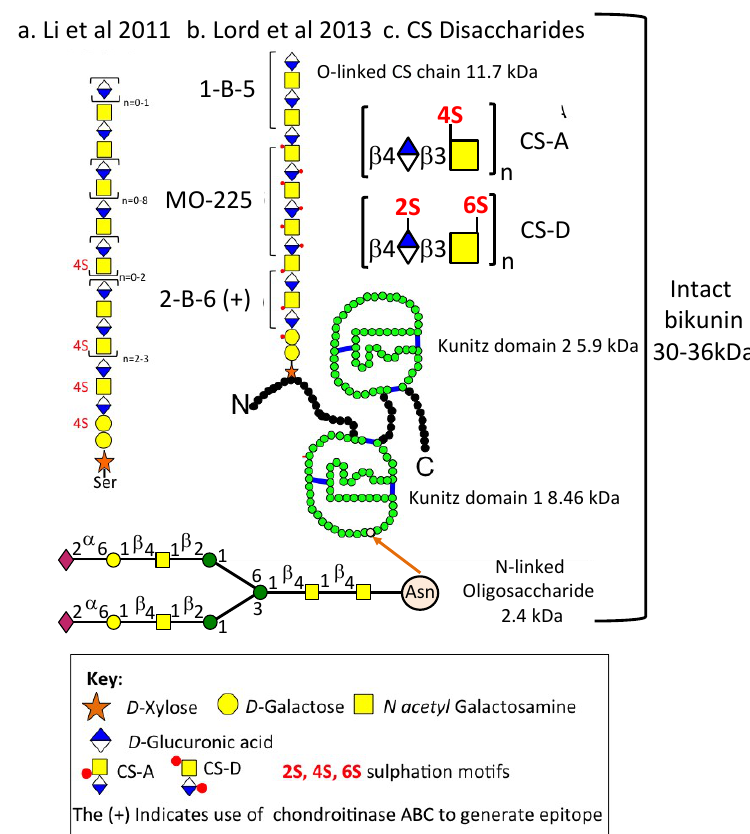
Figure 7. Sequence of the CS chain of bikunin as proposed by Ly et al. 2011 [11] ( a ) and Lord et al. 2013 [10] ( b ). The KPI SPI domains are shown in ( b ). and the attached N -glycan chain of KPI-1. The over-sulfated CS-D disaccharide is shown which forms part of the MO-225 epitope embedded in the CS-A chain of bikunin. Arrangement of sulfated, disulfated and non-sulfated regions of the CS chain of bikunin are shown. The arrow shows the Asparagine residue on Kunitz domain 1.